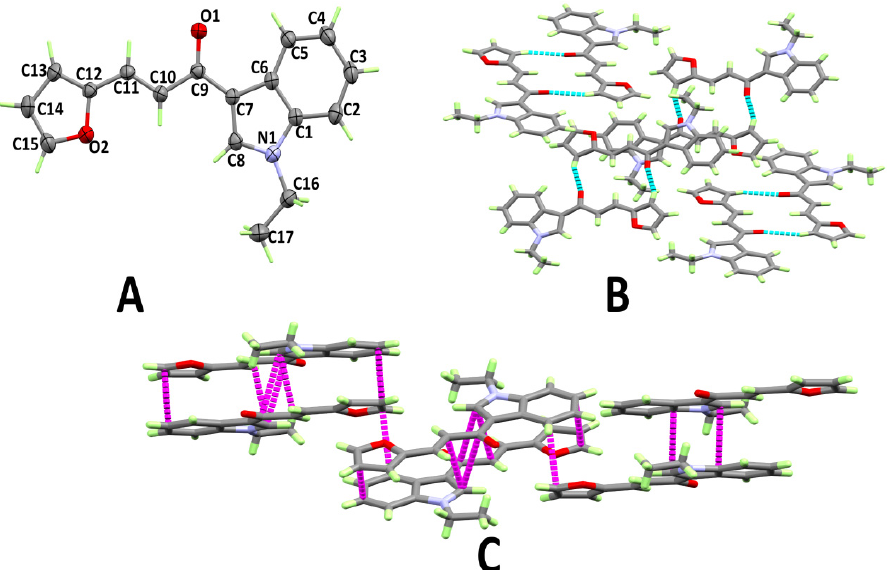
Figure 5. Atom numbering and thermal ellipsoids drawn at 30% probability level ( A ), hydrogen bonds ( B ), and π ··· π ( C ) stacking interactions in 3e . Table 1. Hydrogen bond parameters in the studied compounds.